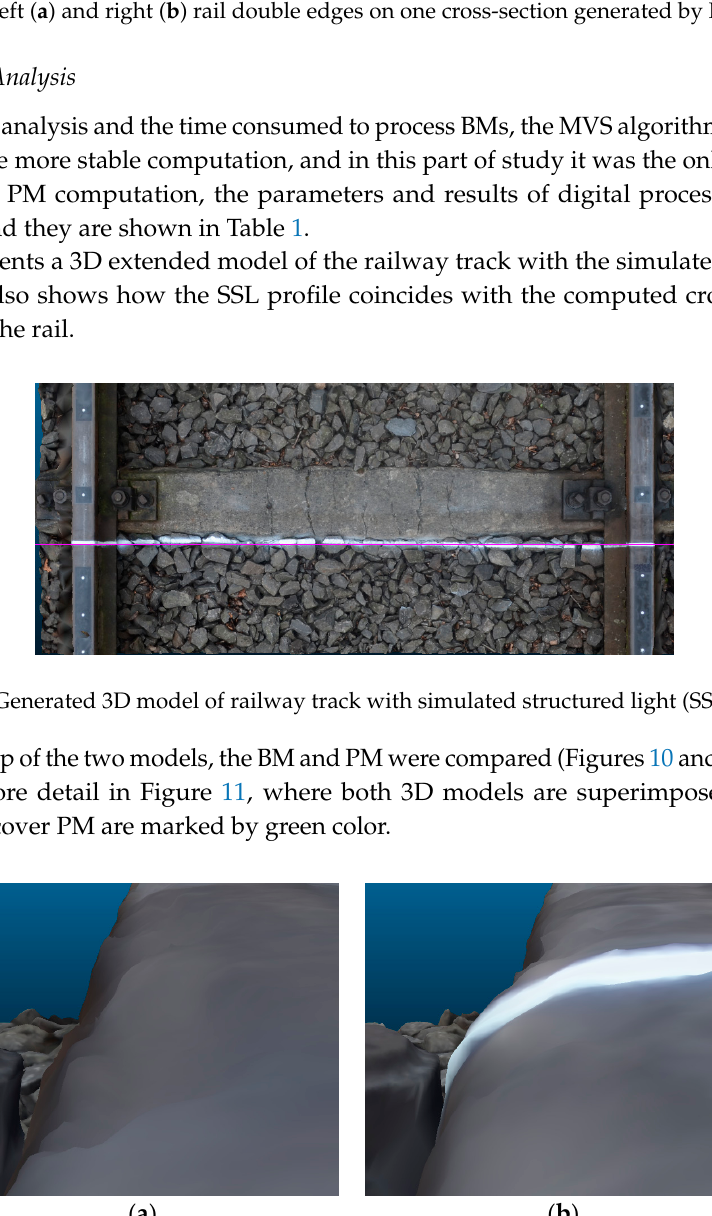
Figure 10. Right rail track 3D model without ( a ) and with ( b ) SSL profile.